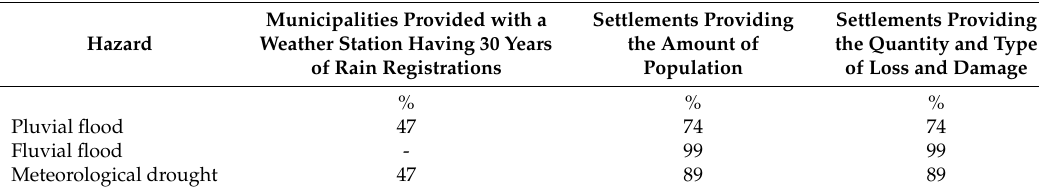
Table 8. Information